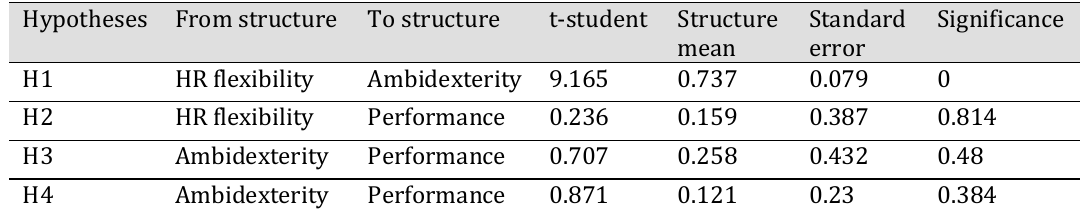
Table 6. Linear effects of the first hypothesis components.